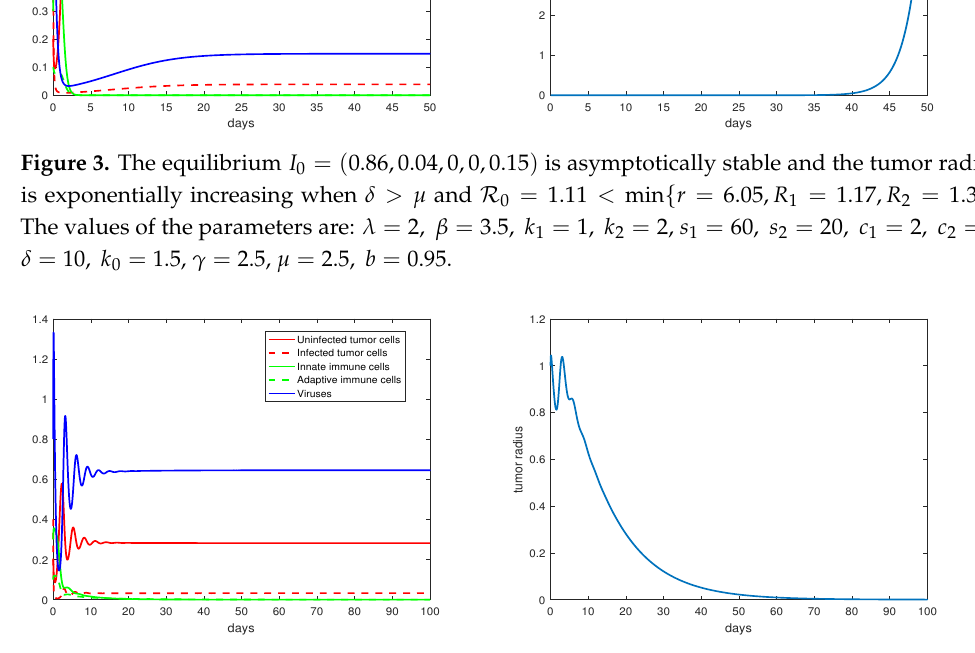
Figure 4. The equilibrium I 0 = ( 0.28,0.03,0,0,0.65 ) is asymptotically stable and the tumor radius is exponentially decreasing when δ > µ and R 0 = 3.18 < min { r = 6.05, R 1 = 4.42, R 2 = 3.60 } . The values of the parameters are: λ = 2, β = 3.5, k 1 = 1, k 2 = 2, s 1 = 22, s 2 = 21, c 1 = 1.1, c 2 = 1, δ = 20, k 0 = 1.5, γ = 2.5, µ = 1.2, b = 2.5.